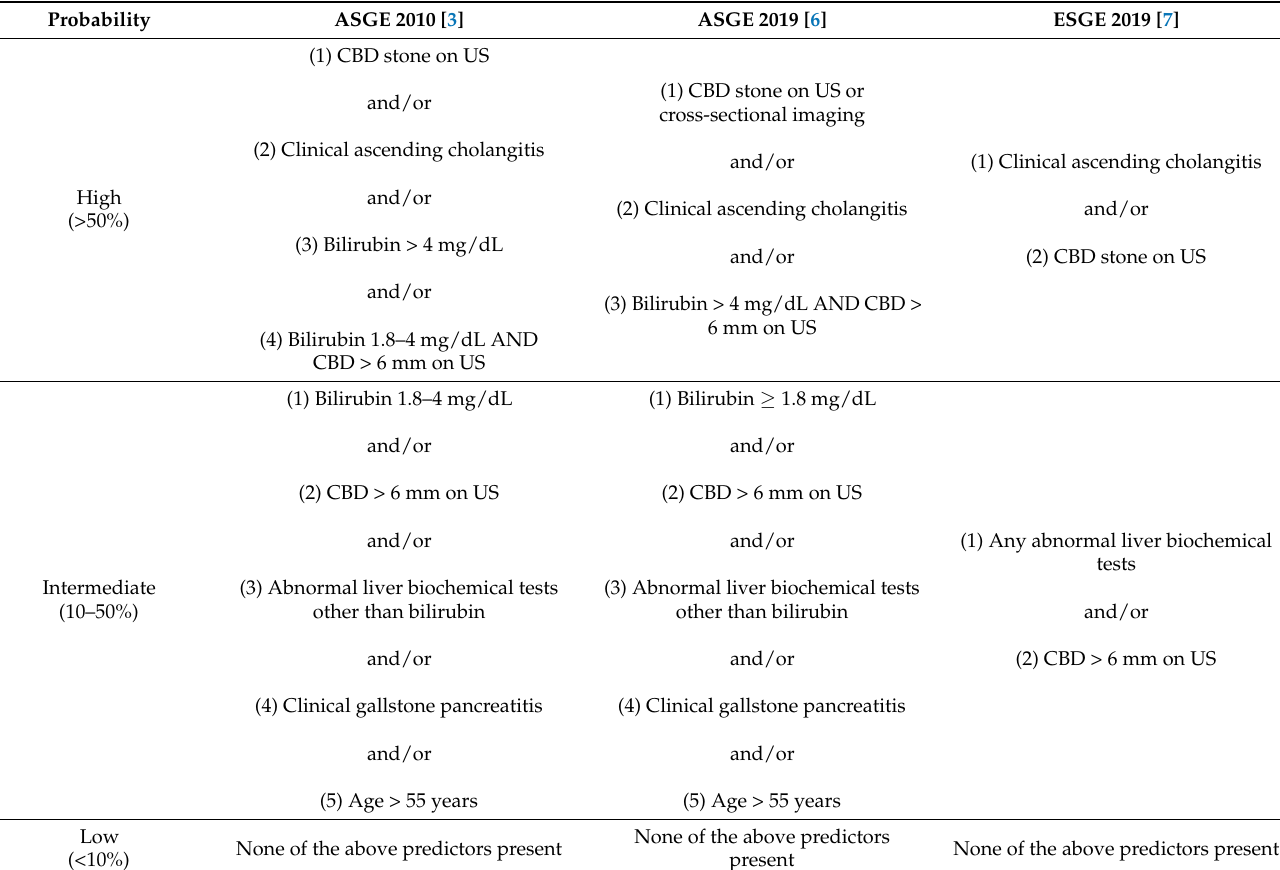
Table 1. Summary of ASGE 2010, ASGE 2019, and ESGE 2019 recommendations regarding the pre-test probability of